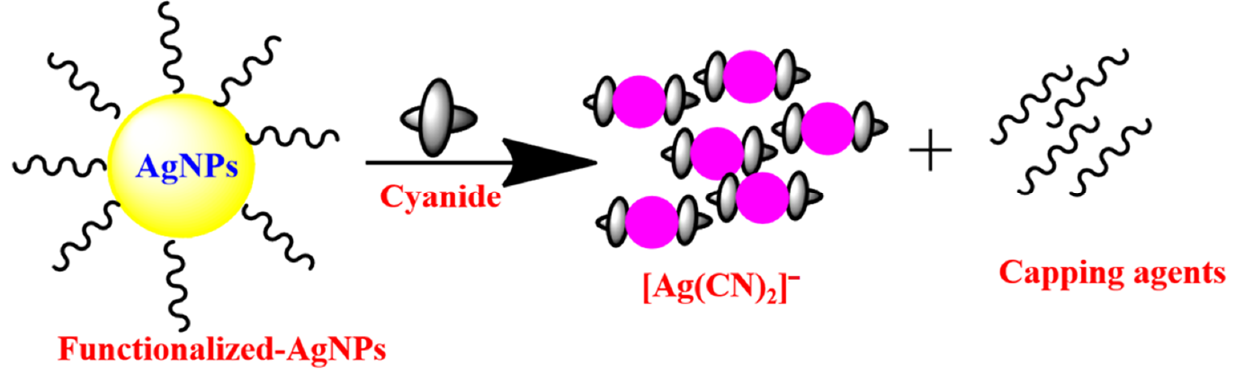
Figure 1. Probable sensing mechanism for AgNP-based colorimetric sensor for cyanide anion.